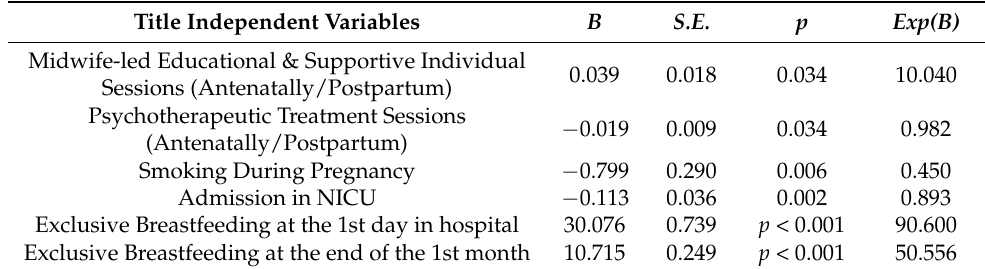
Table 3. Logistic Regression Analysis Model with the Dependent Variable “Breastfeeding Exclusivity at the end of the 6th month